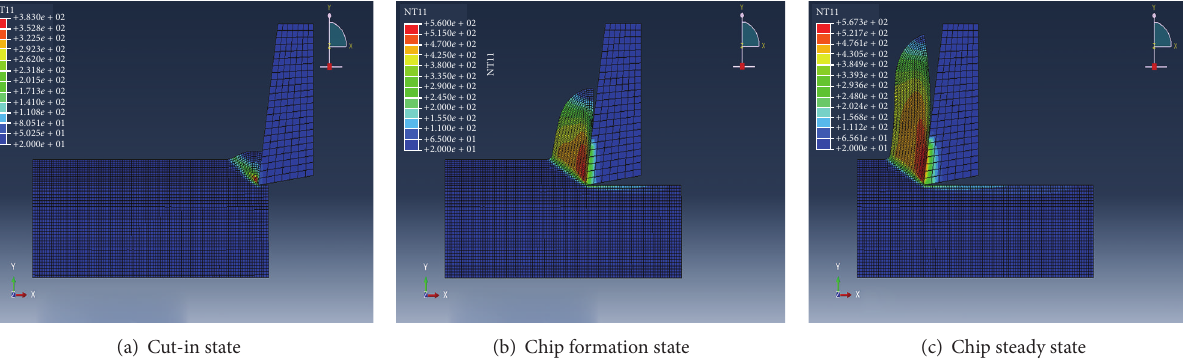
Figure 5: The temperature distribution of cutting speed of 254 m/min.